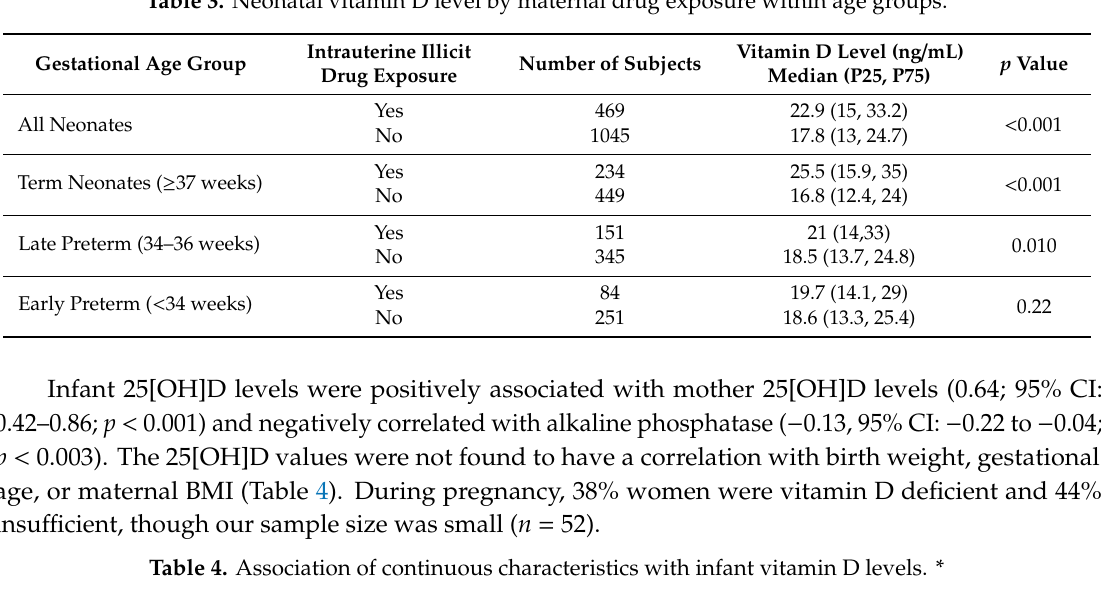
Table 3. Neonatal vitamin D level by maternal drug exposure within age groups.